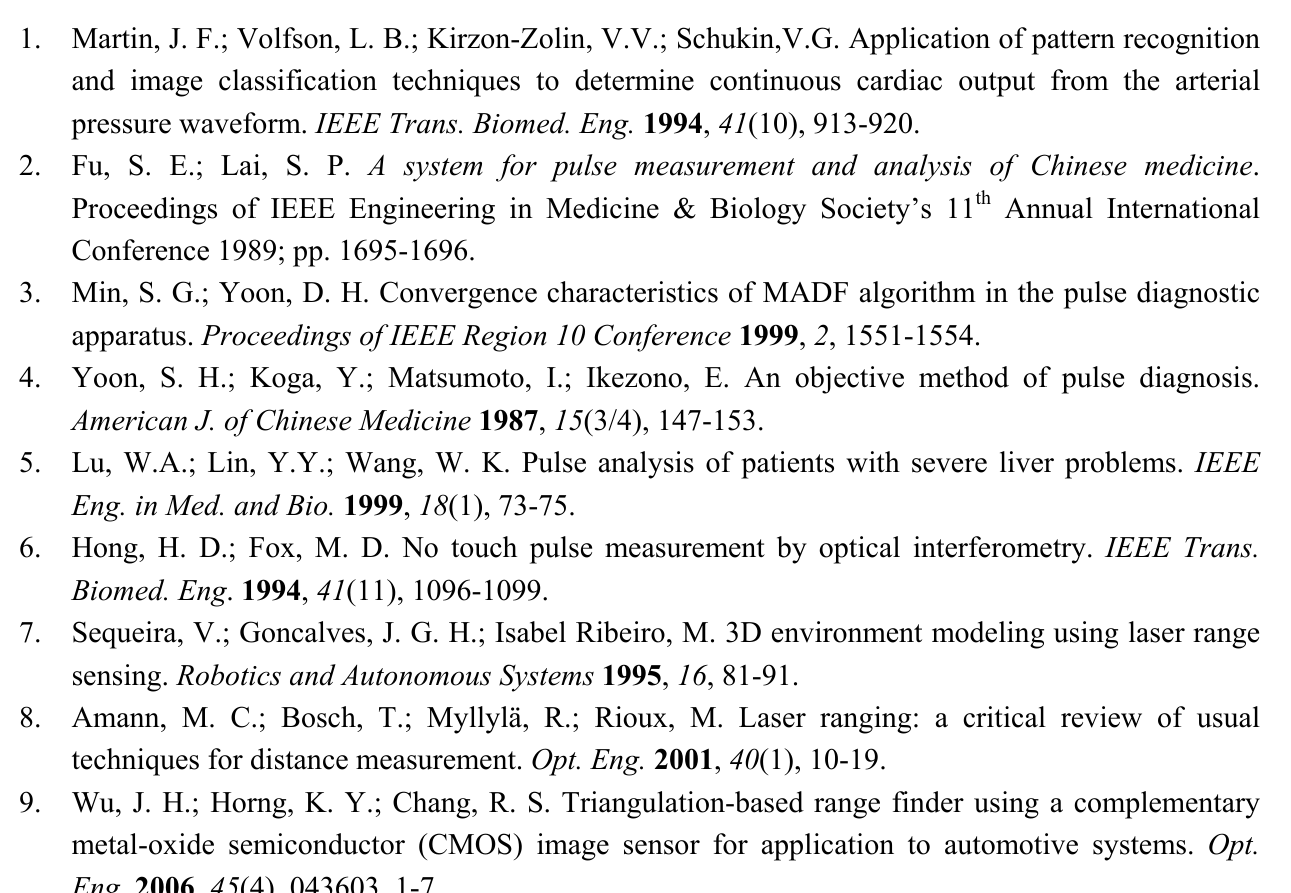
Figure 13. Pulse information for the Guan point on the left hand (liver) of the tested subject ( continued ): (b) after staying up